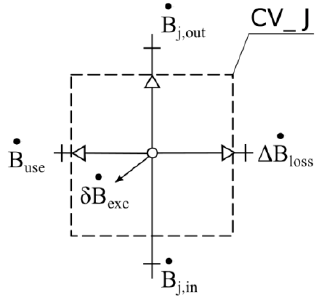
Figure 5. Exergy model for nodes.